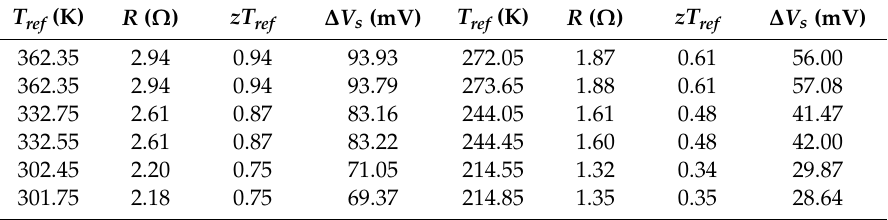
Table 4. Peltier module a.3: p - n series resistance, the figure of merit, and Seebeck voltage ( I = 41 mA). T ref (K)